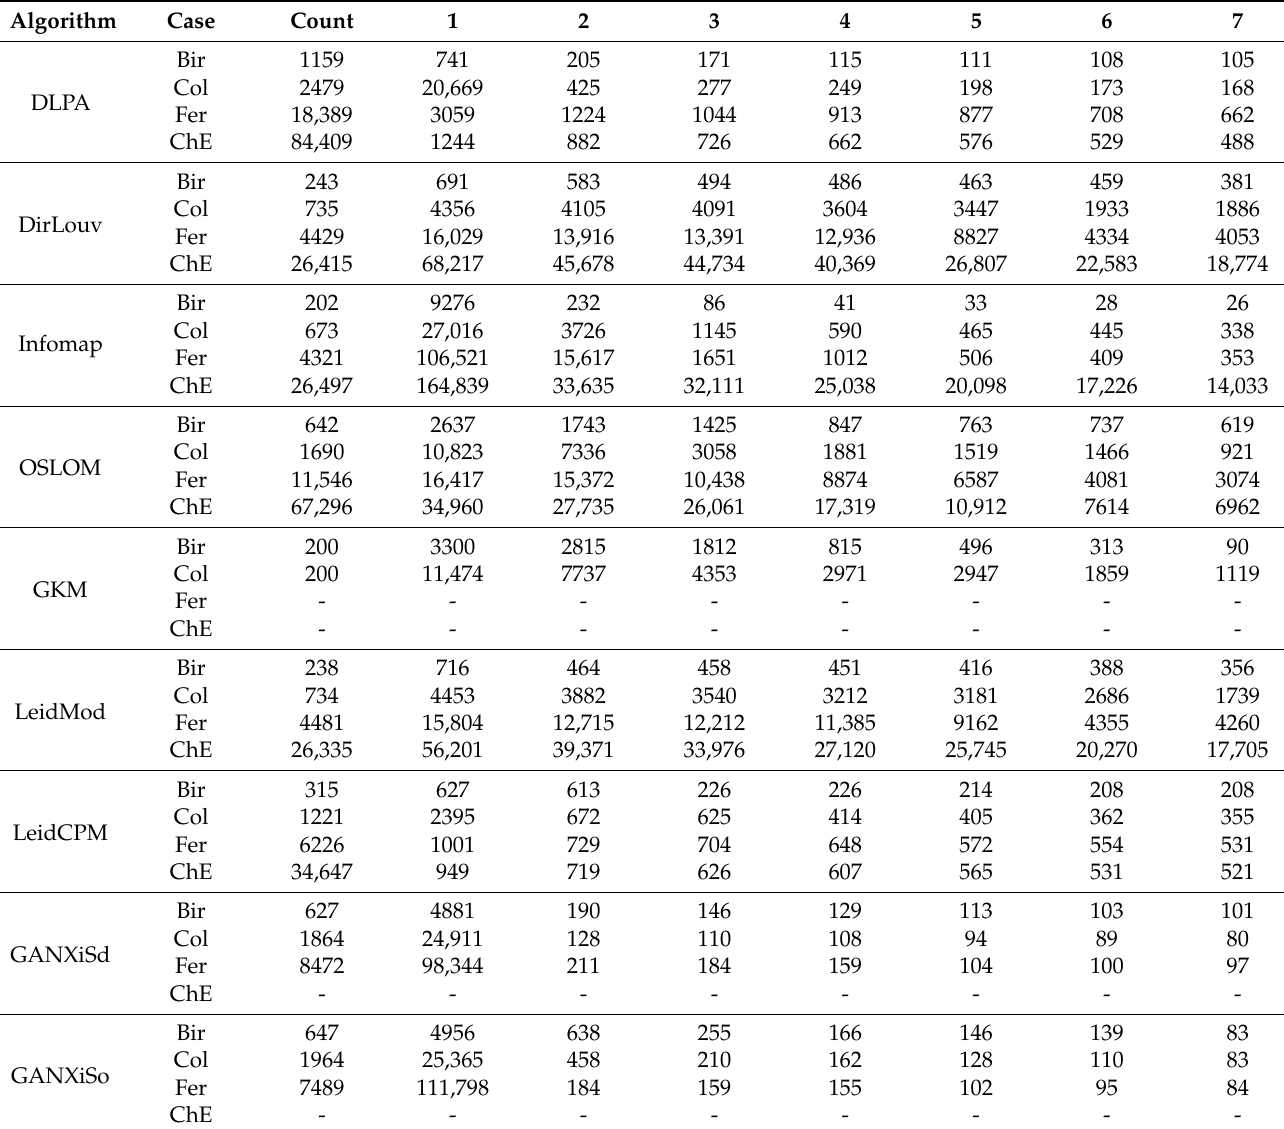
Table A2. The number of communities obtained as compared by algorithm and the seven largest communities, summary